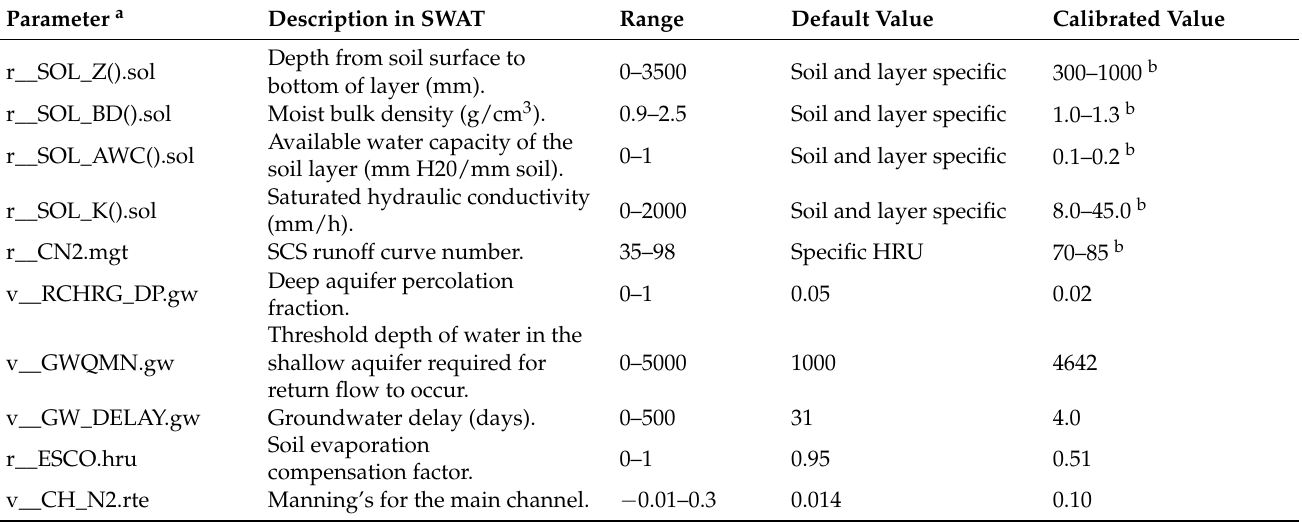
Table 3. Sensitivity analysis rankings for streamflow model output.